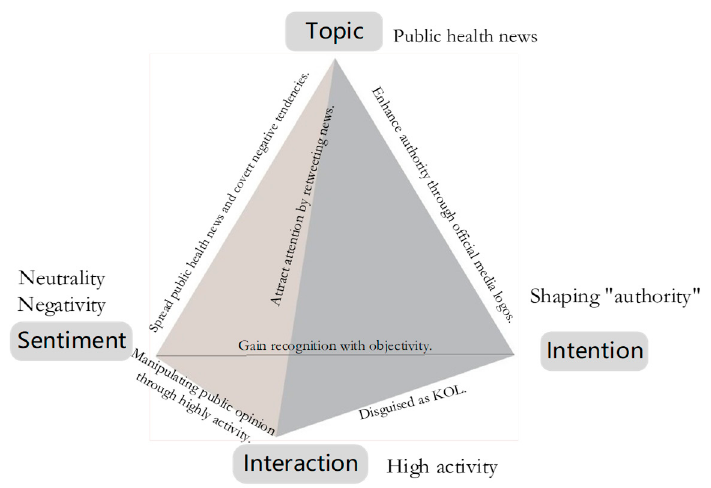
Figure 14. User persona of social bots in COVID-19 pandemic discussion on Twitter.